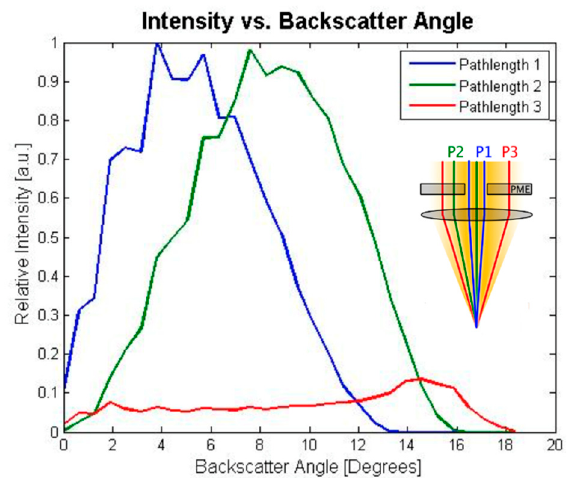
Figure 4. The distribution of backscattering angles in the Monte Carlo simulation for three pathlengths. Pathlength 1 contains the smallest scattering angles, and is most distinguished from Pathlength 2. Pathlength 3 contains both high- and low-angle backscattering and is thus degenerate. Permission was granted by the publisher to reprint this figure from Gardner et al. with minor modifications [19].